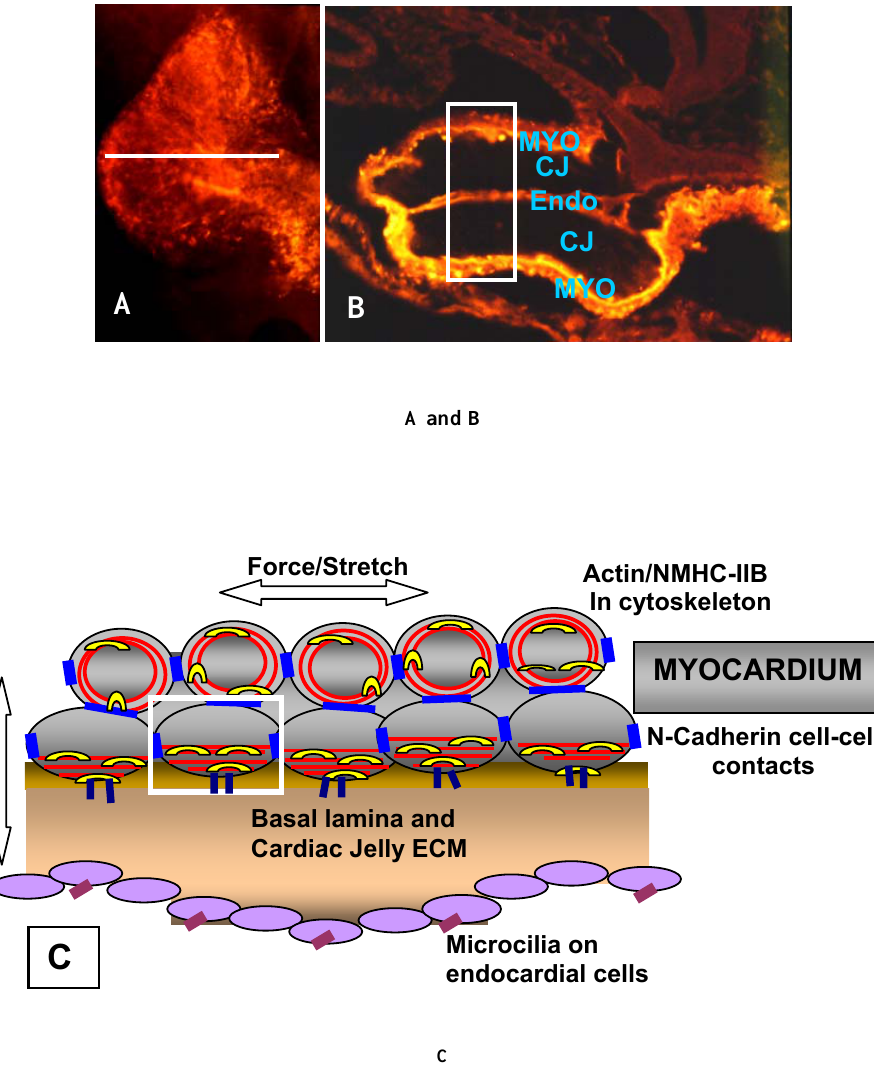
FIGURE 2. A hypothetical model based on current literature shows the cytoskeleton at the “hub” of cross-talk between cell-to-cell and cell-to- matrix interactions that are involved via signaling pathways in coordinating development of cardiac form and function. Accumulating evidence suggests that the cytoskeletal signaling involves interactions between the nonmuscle myosin II (NMHC-II) class of motor proteins and actin. Fig. 2A depicts a looping stage 11 chick heart immunostained for flectin. Section (plane of section depicted by white line) through the heart is shown in panel 2B showing the relationship (see boxed in region) of the myocardial (Myo) wall, basal lamina/cardiac jelly (CJ), and endocardium (Endo). Fig. 2C shows a diagram of a general model depicting the organization of the actin[48] (red fibers) and nonmuscle myosin (yellow arcs) in the inner and outer layer of the two-layered myocardium during the looping stages 11/12 in the chick heart. Basal lamina and cardiac jelly are shown, as well as the monociliated endocardial cells that are able to detect shear stresses of blood flow. Block arrows depict stretch and force on the cardiac